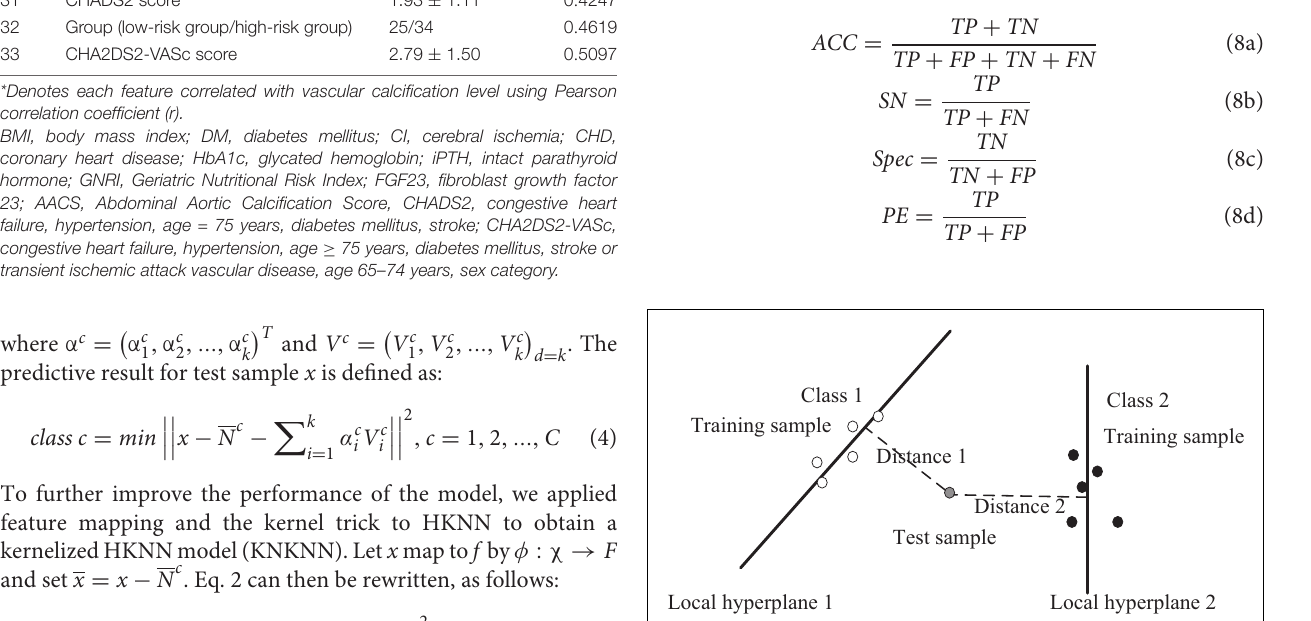
FIGURE 1 | The schematic diagram of